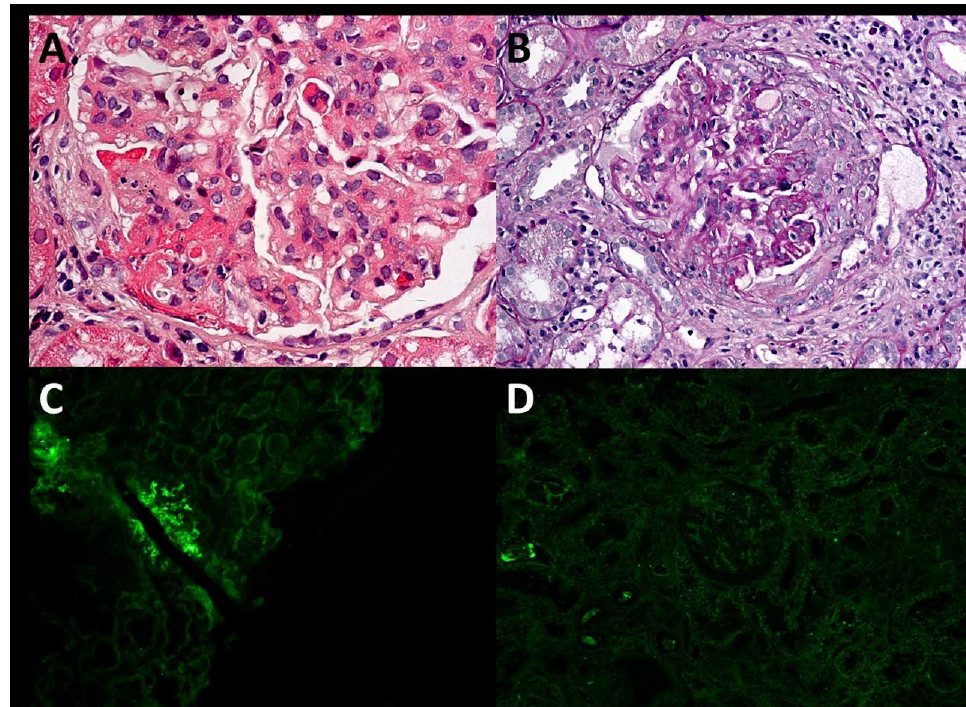
Figure 1. Renal histopathology. Light microscopy ( A , B ), immunofluorescence ( C , D ). ( A ) Diffuse mesangial and segmental endothelial hypercellularity with segmental necrosis and glomerular neutrophil infiltration (haematoxylin and eosin, 400 × ). ( B ) A cellular crescent (periodic acid-silver methenamine, 200 × ). ( C ), C3 (++) deposition in mesangial areas and capillary loops. ( D ) No IgA deposition.